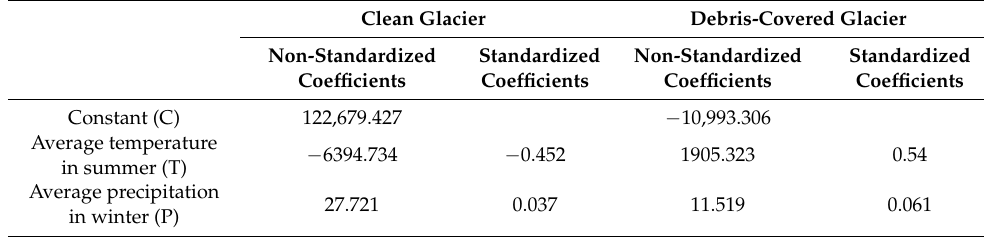
Table 4. Multiple linear regression results.